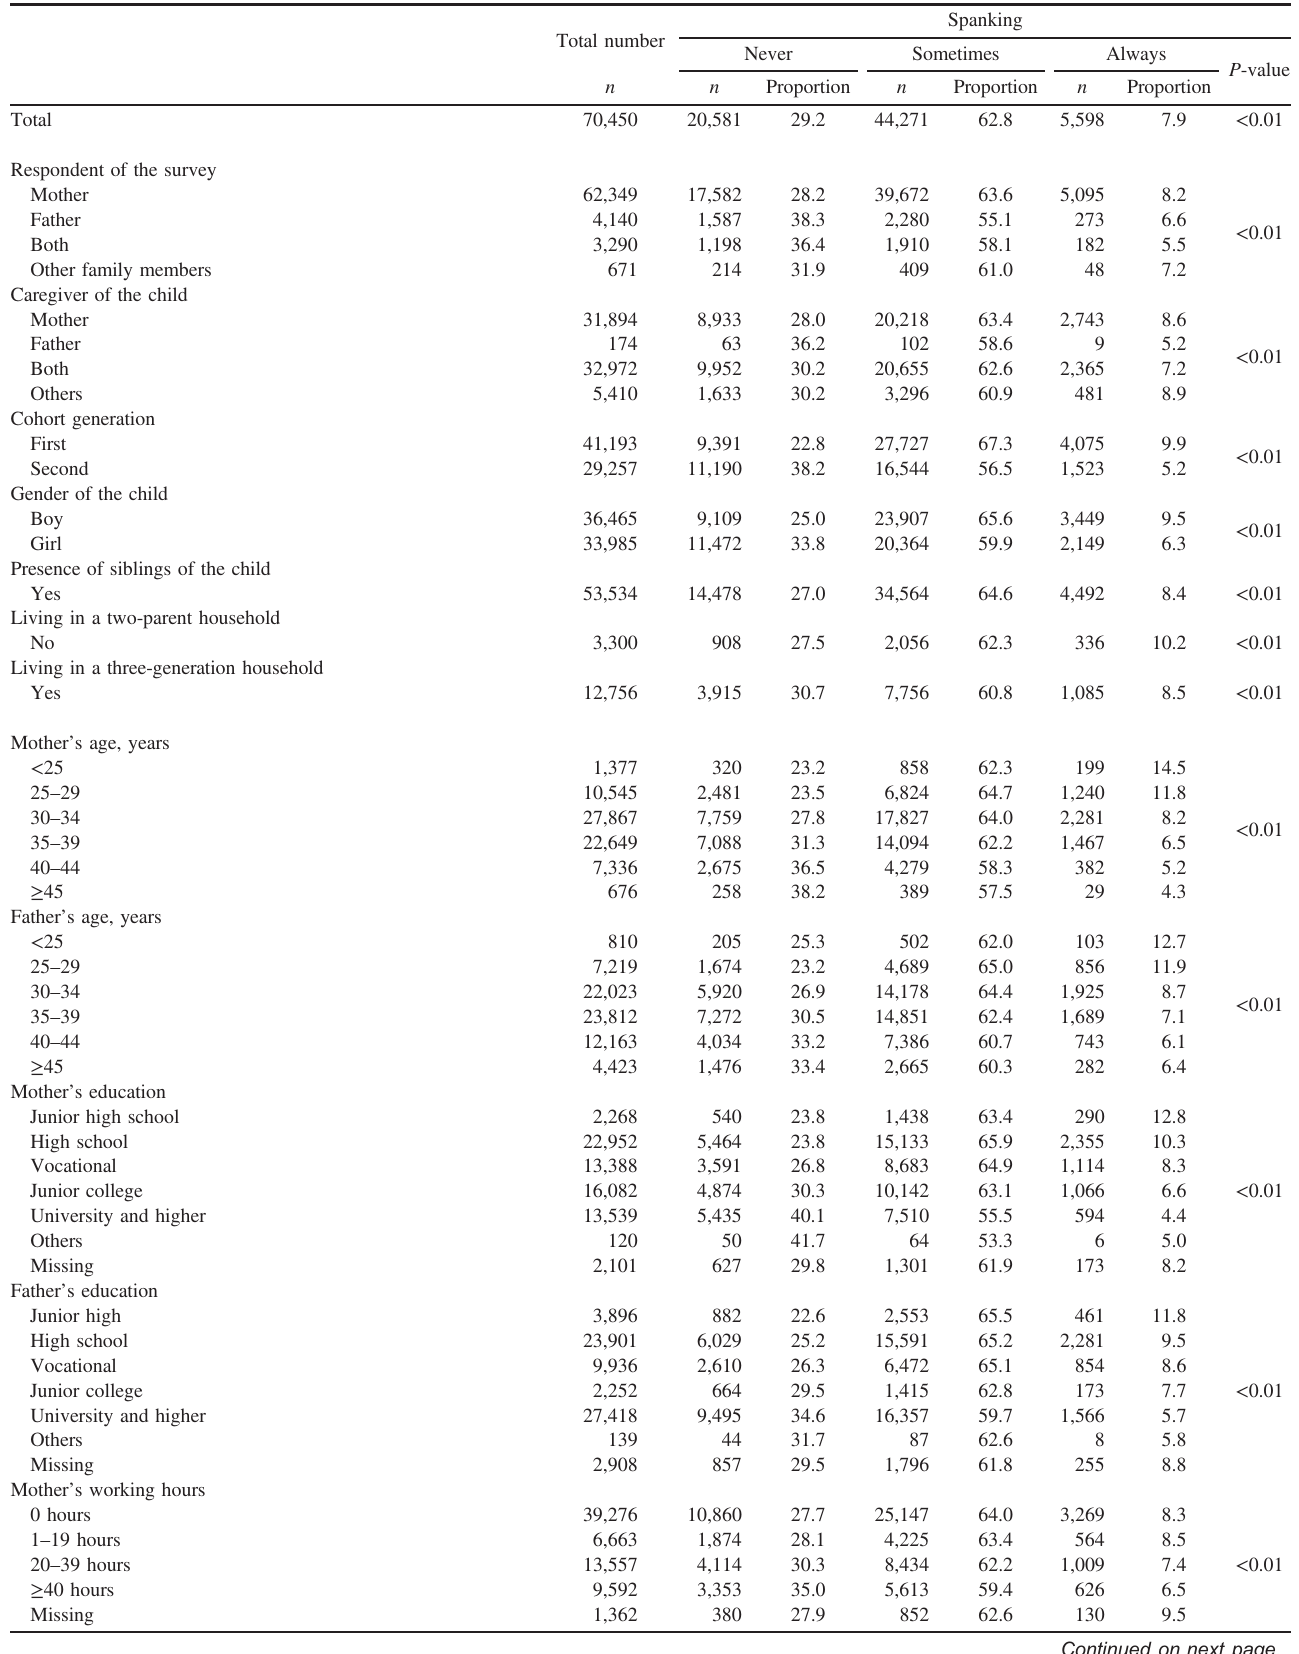
Table 2. Characteristics of participants